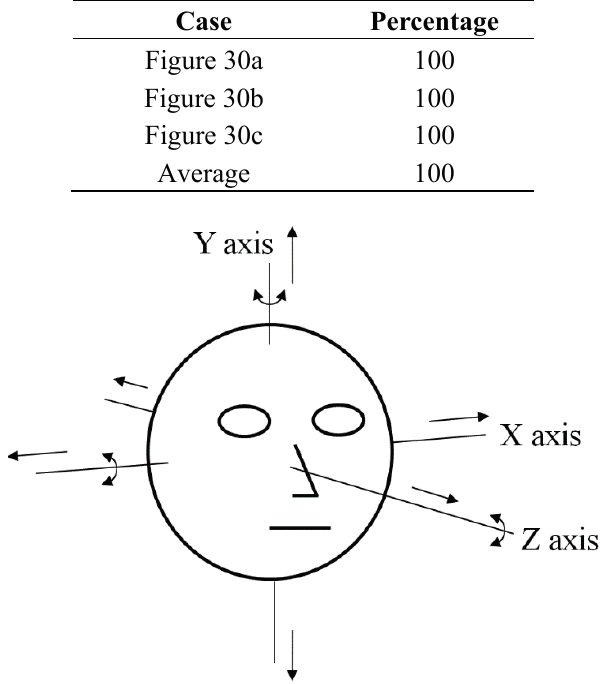
Table 4. The percentage of correctly labeled image of genuine SR versus total number of image in case of sunlight (unit: %).